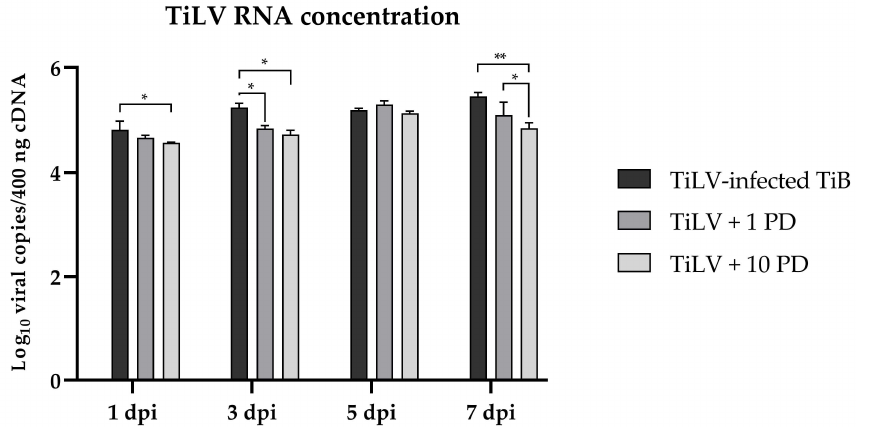
Figure 5. Comparison of TiLV RNA copies in TiB cells exposed to TiLV and PD, TiLV with 1 µM PD and TiLV with 10 µM PD (n = 3 each). The data are presented as means ± SEMs. * p < 0.05, ** p < 0.01.